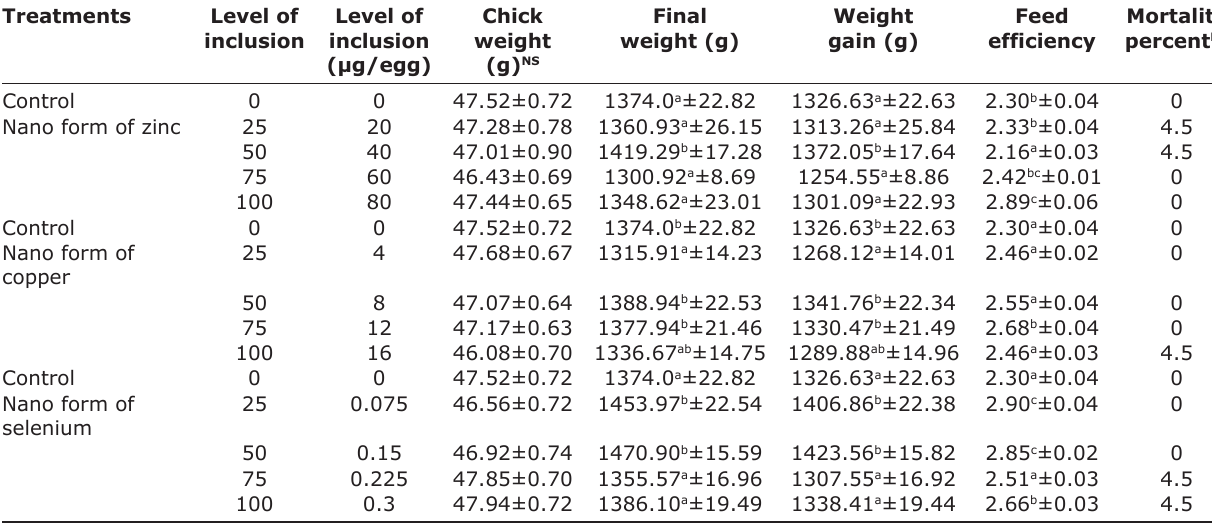
Table-5: Effect of in ovo feeding of broiler eggs with nano form of zinc, copper and selenium at graded levels on overall weight gain, feed efficiency and mortality of broilers (0-5 weeks)*.